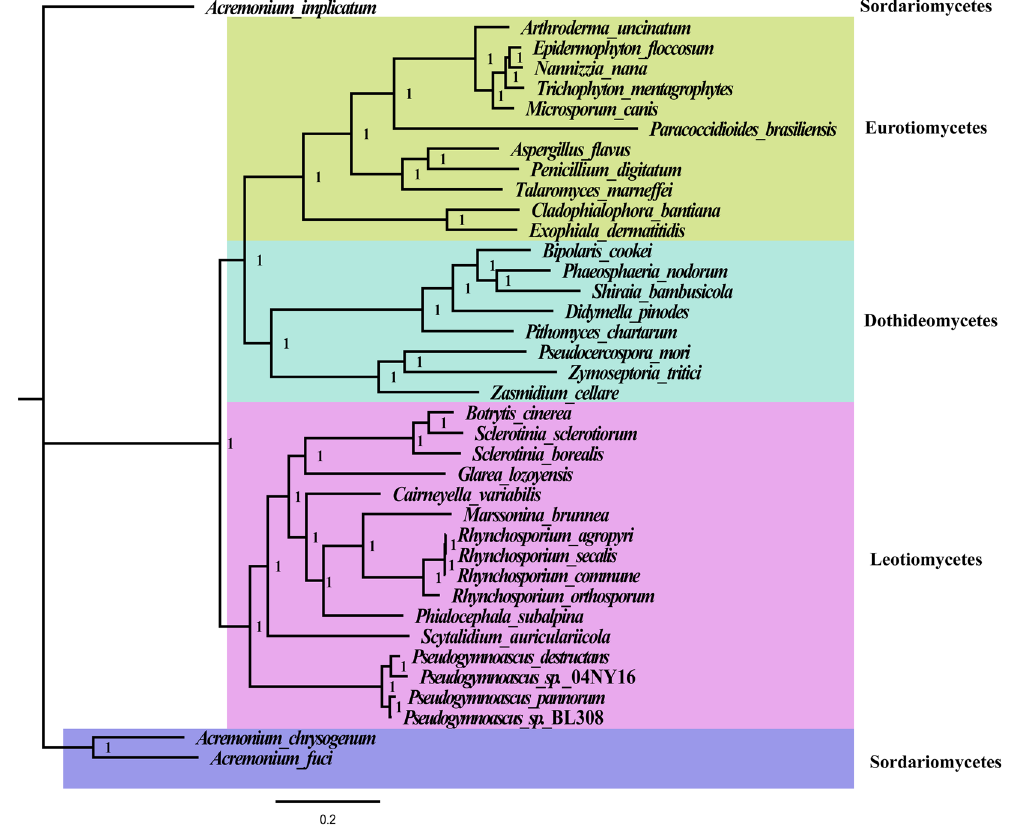
Figure 6. The phylogenetic tree was calculated from the multiple sequence alignment of the combined mitochondrial gene set (15 PCGs) of 38 fungal species. Topology was inferred using Bayesian method. Species analysed are shown in Table S9. The phylogenetic tree was drawn using the Figtree v1.4.3 software (https://mac.